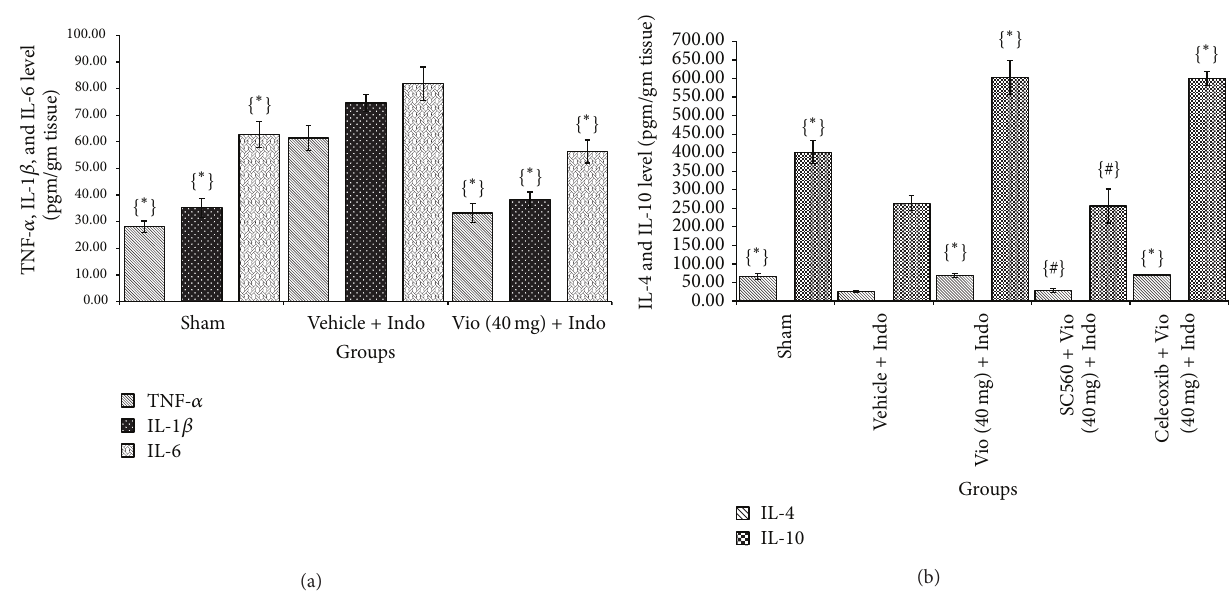
Figure 6: (a) Effect of violacein (40 mg/kg, orally) on proinflammatory cytokines (TNF- 𝛼 , IL-1 𝛽 , and IL-6) level; (b) anti-inflammatory cytokines (IL-4 and IL-10) level in indomethacin-induced ulcer. Values are mean ± SD ( 𝑛 = 6 ). ∗ 𝑃 < 0.05 compare vehicle + Indo with all the groups; # 𝑃 < 0.05 compare Vio (40mg) + Indo with SC560 (or) Celecoxib + Vio (40 mg) + Indo. Indo: indomethacin; Vio: violacein.